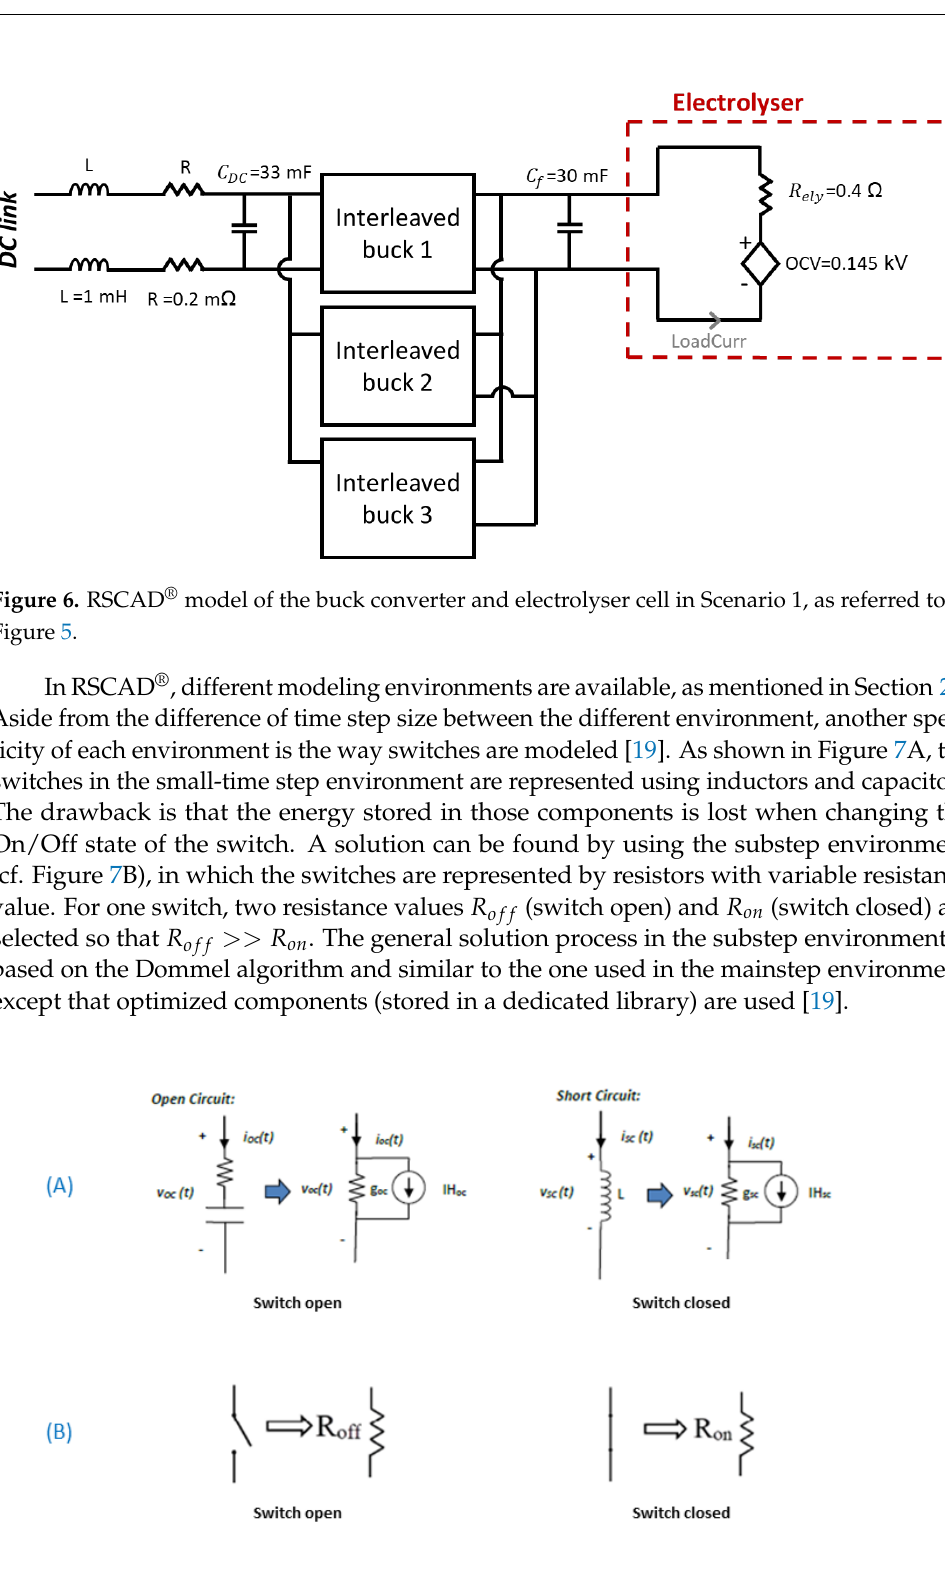
Figure 7. Switch representation in RSCAD ® in ( A ) the small time-step environment and ( B ) the substep